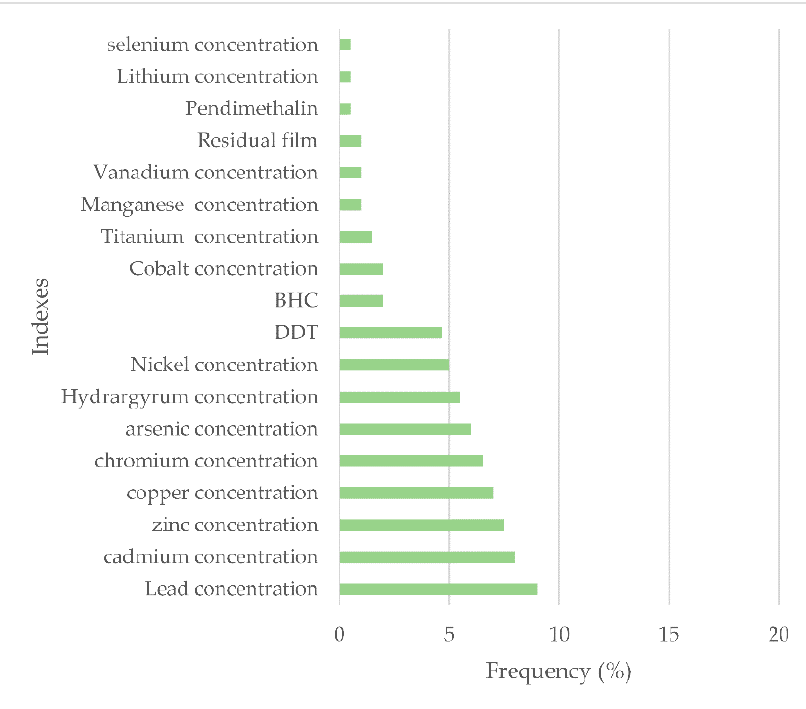
Figure 4. Soil environment evaluation indices.